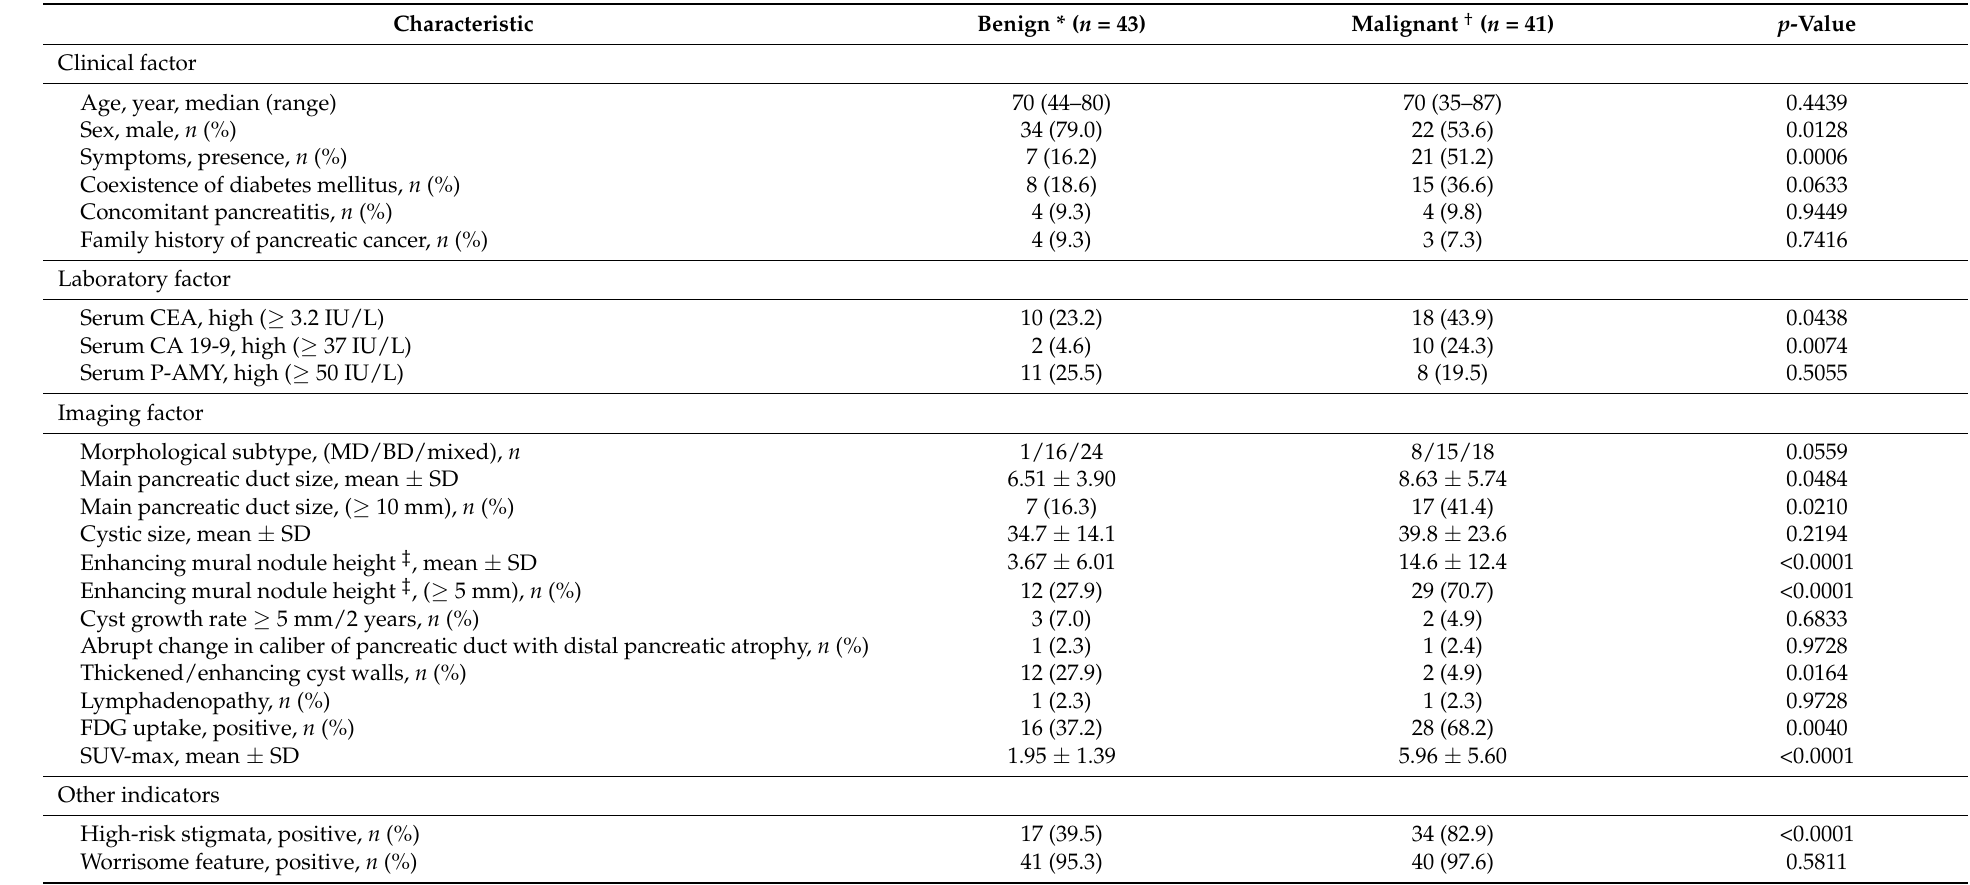
Table 2. Clinicopathological features between the benign and malignant